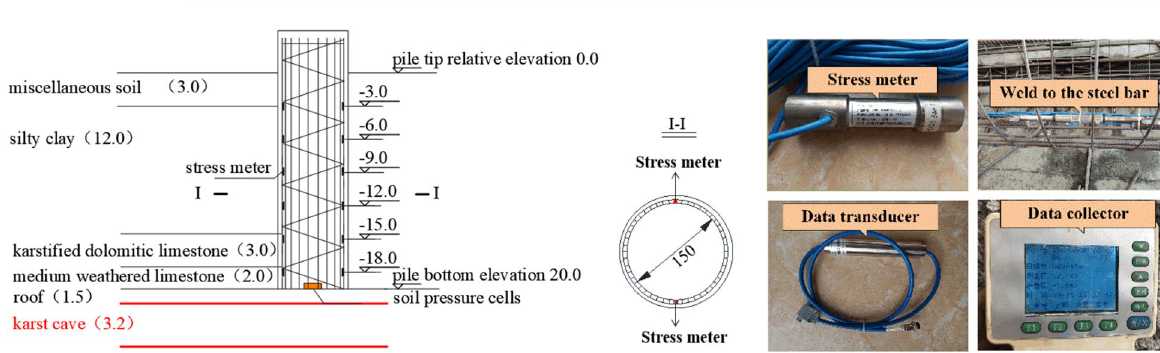
Figure 3. Displacement meter and strain gauge layout.